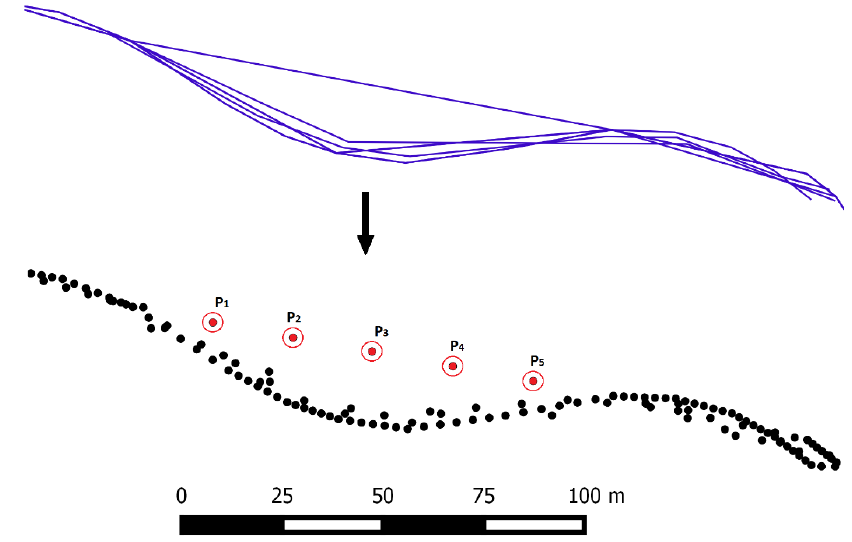
Figure 14. An example of identifying outlier points in all versions of an object.